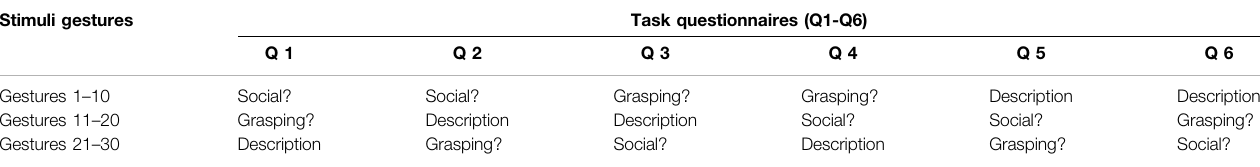
TABLE 3 | Each group of participants viewed the same 30 gestures in the same order, but completed different questionnaires. The questionnaires contained three types of tasks (social, grasping, and description). The tasks were thus presented in a counterbalanced order for each group according to 10 gestures each. Stimuli gestures Task questionnaires